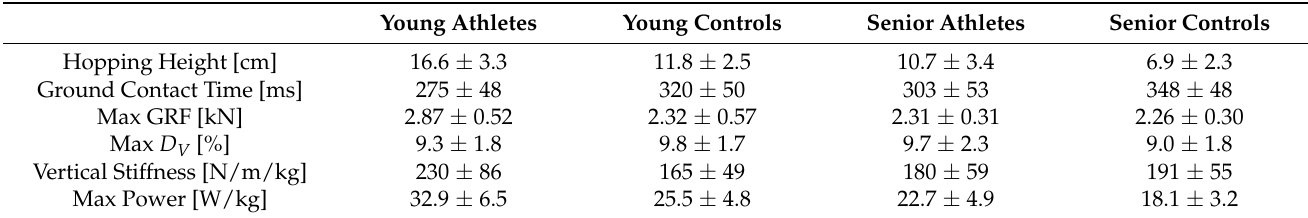
Table 2. Biomechanical parameters of the multiple one-legged hopping